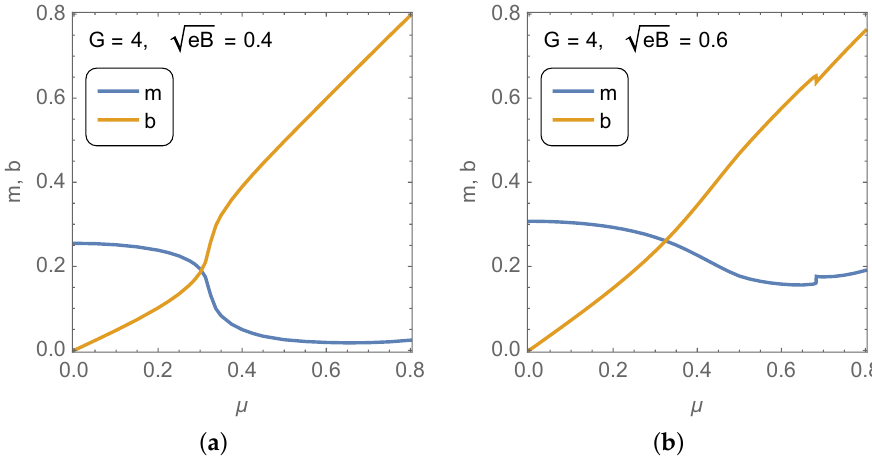
Figure 2. Solutions of the MDCDW gap equations versus the quark chemical potential at supercritical coupling ( G = 4) and magnetic fields ( a )